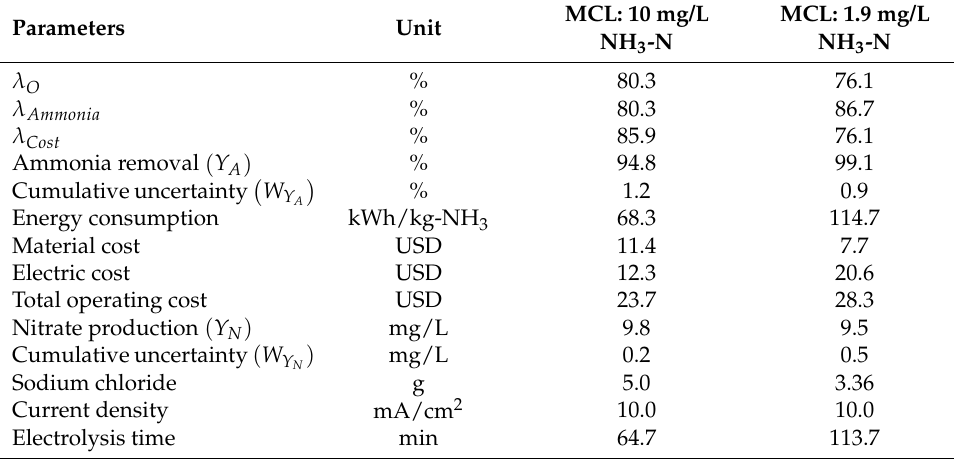
Table 3. Fuzzy optimal results in the electro-oxidation process based on maximum contaminant levels (MCL) in United States Environmental Protection